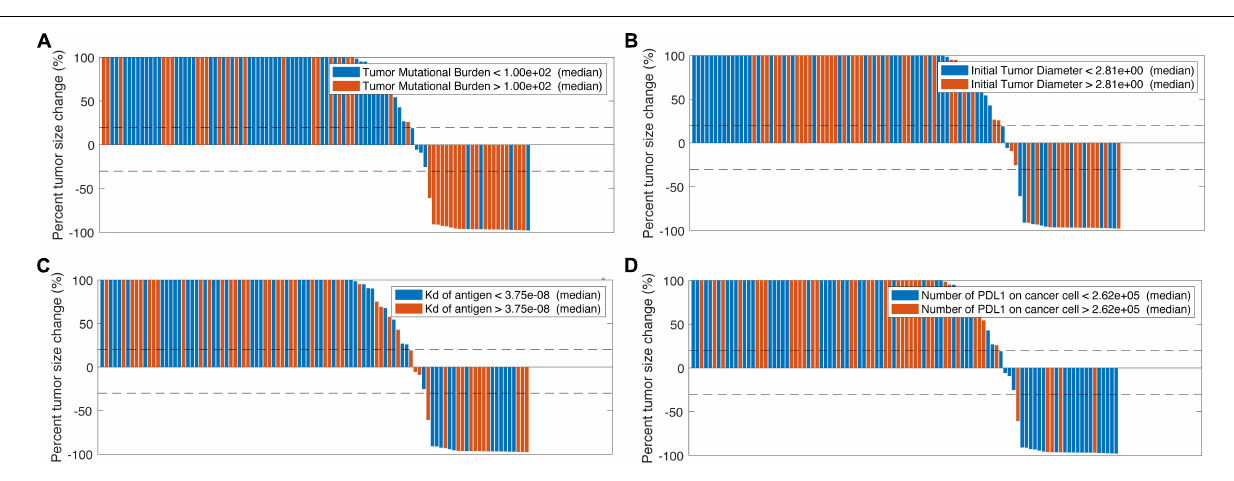
FIGURE 5 | Change from baseline in model-predicted tumor diameter assessed by RECIST v1.1 based on tumor mutational burden (A) , initial tumor diameter (B) , tumor antigen binding affinity (C) , and number of PD-L1 molecules on cancer cells (D)